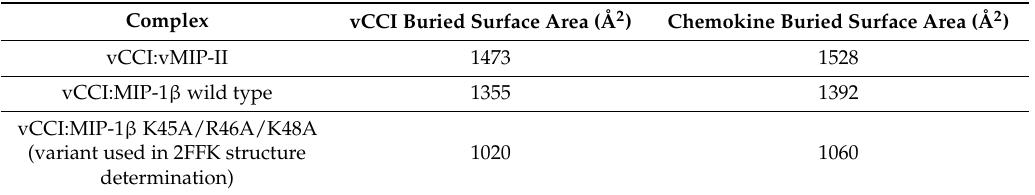
Table 2. Buried surface area between vCCI and chemokine variants averaged over 51 structures analyzed during the final 500 ns of